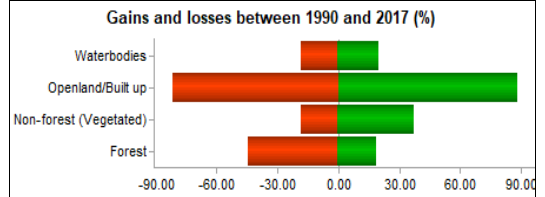
Figure 3. Gain (green) and loss (red) of land use class between 1990 to 2017